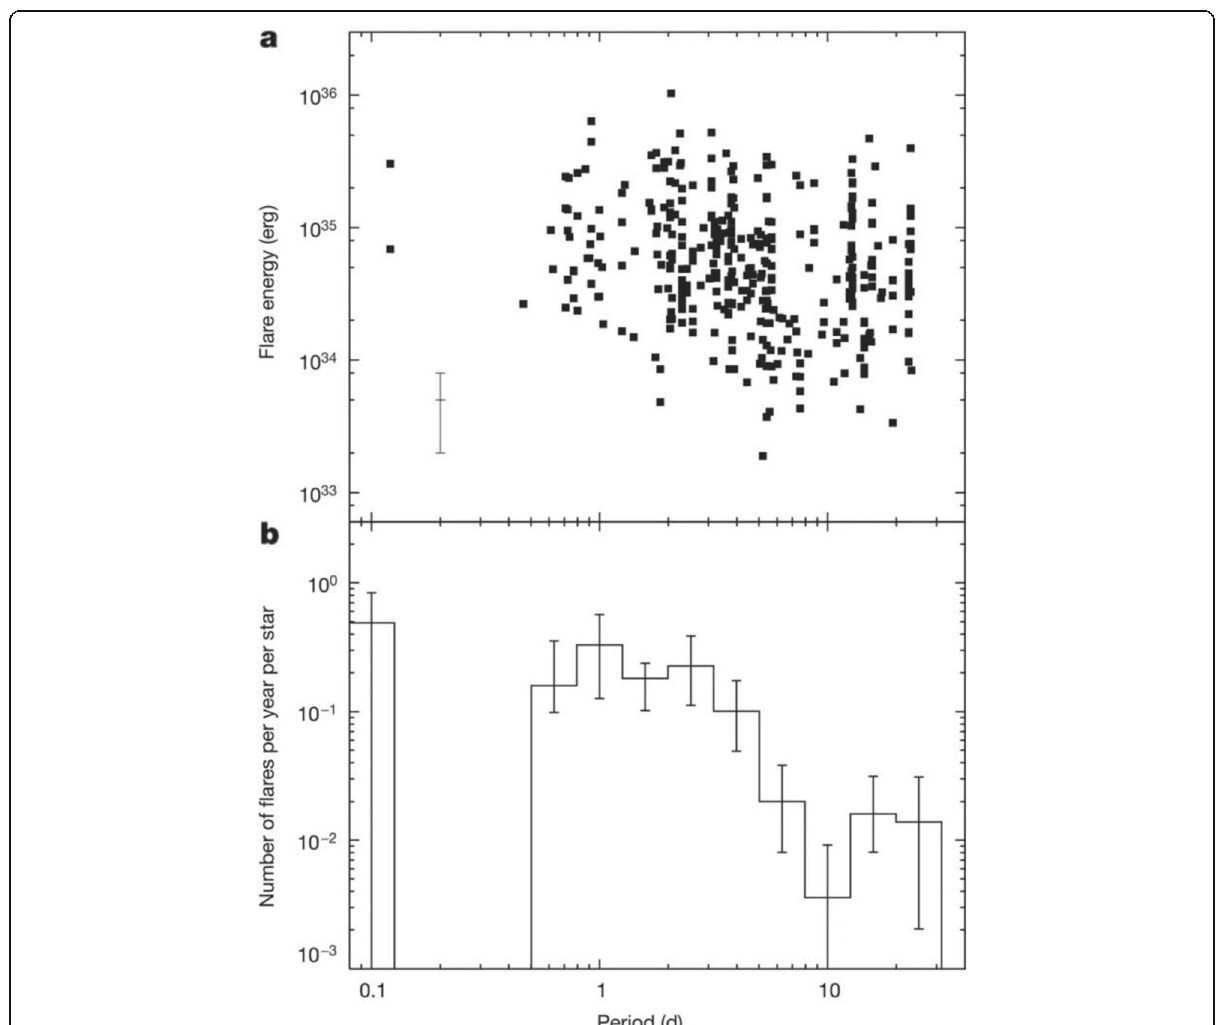
Fig. 13 Stellar superflares. The top panel shows flare energy and the bottom panel shows the frequency of occurrence of flares per year per star versus the period of brightness variation (a proxy for stellar rotation period). These observations show that extremely strong superflares occur more frequently in faster rotating stars and that solar-like stars can in principle produce extremely strong, superflares. Image reproduced